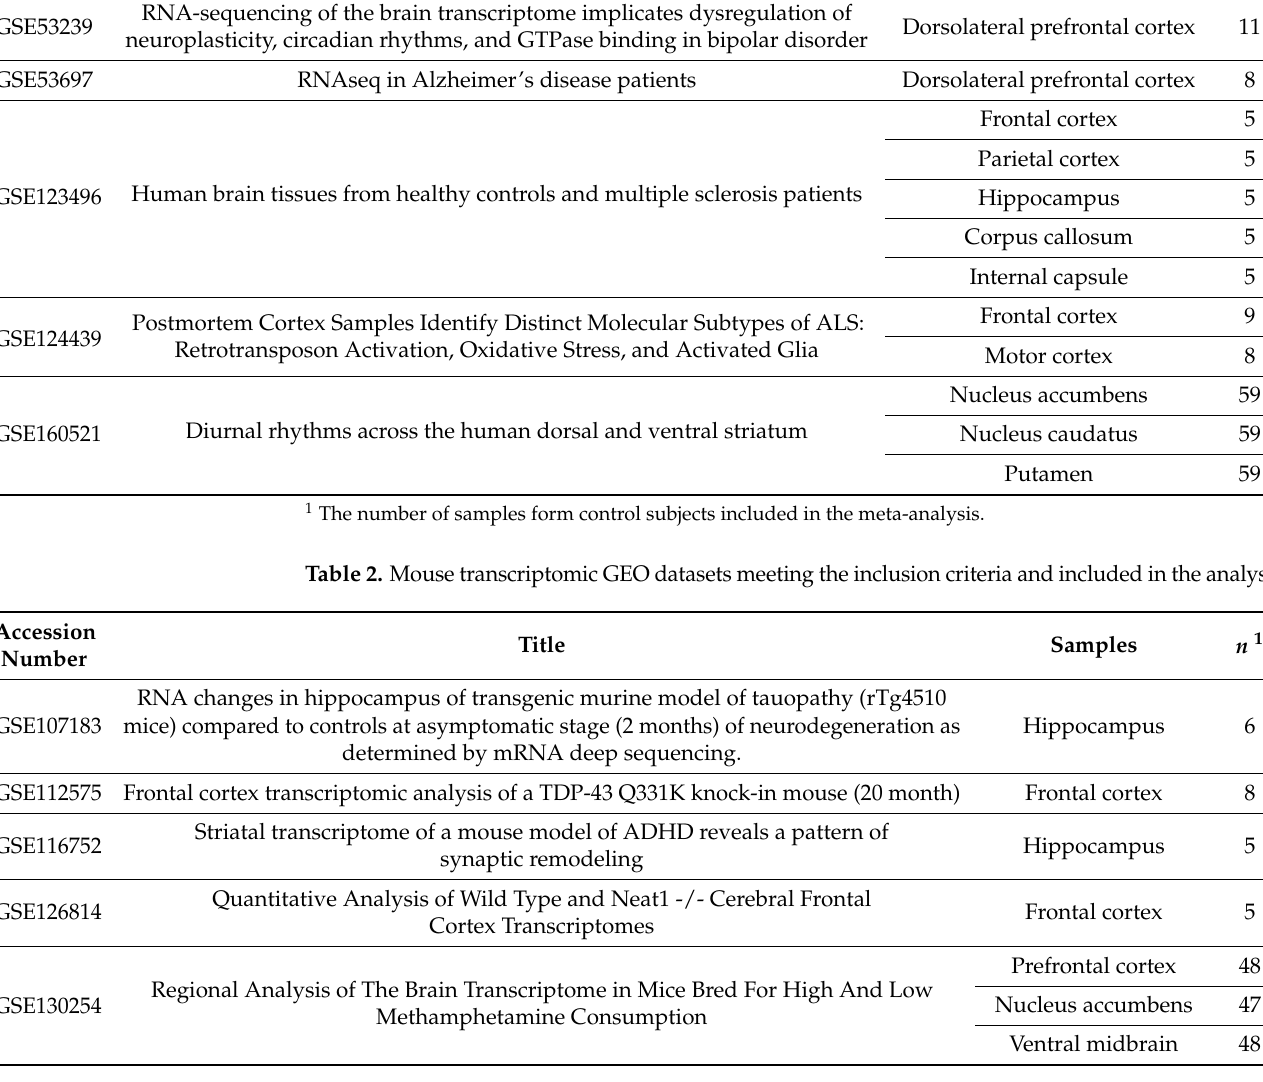
RNA-sequencing of the brain transcriptome implicates dysregulation of neuroplasticity, circadian rhythms, and GTPase binding in bipolar disorder